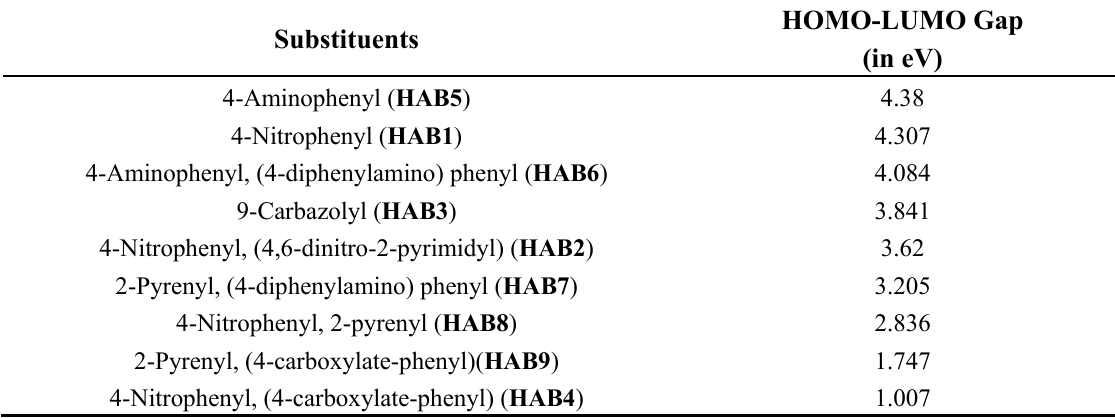
Table 1. Comparison among HOMO-LUMO energy gap of the HAB derivatives under